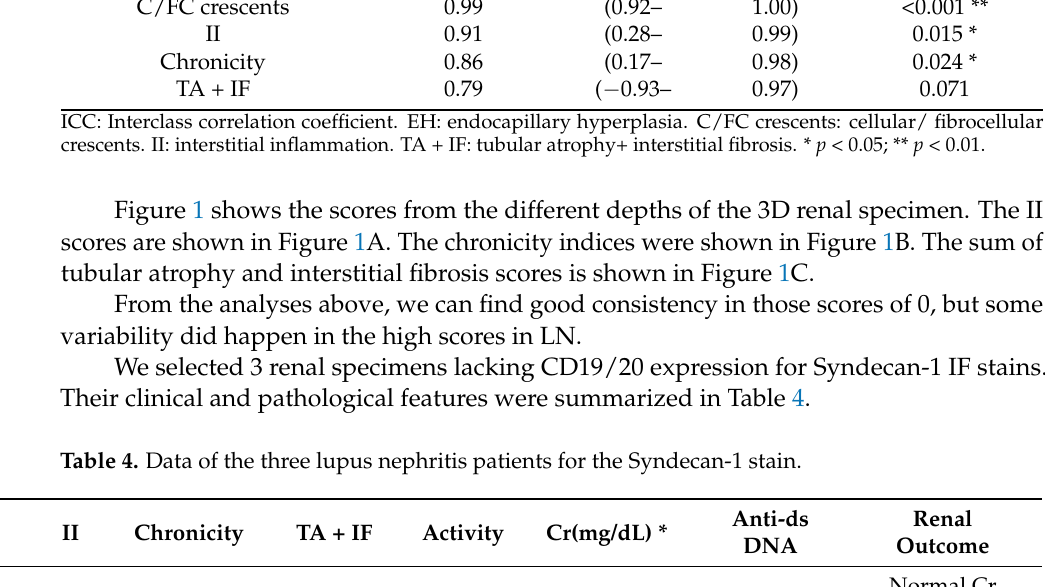
Table 3. Interclass correlation coefficient of different lupus nephritis pathology scores.